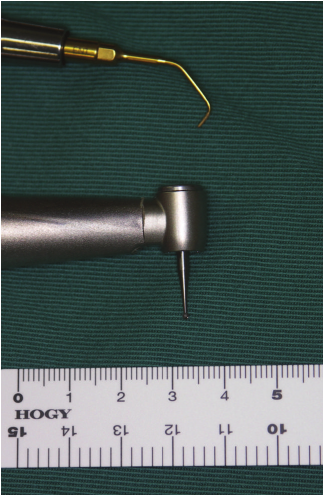
Figure 3: The head of the piezosurgery device is smaller than that of a rotary cutting